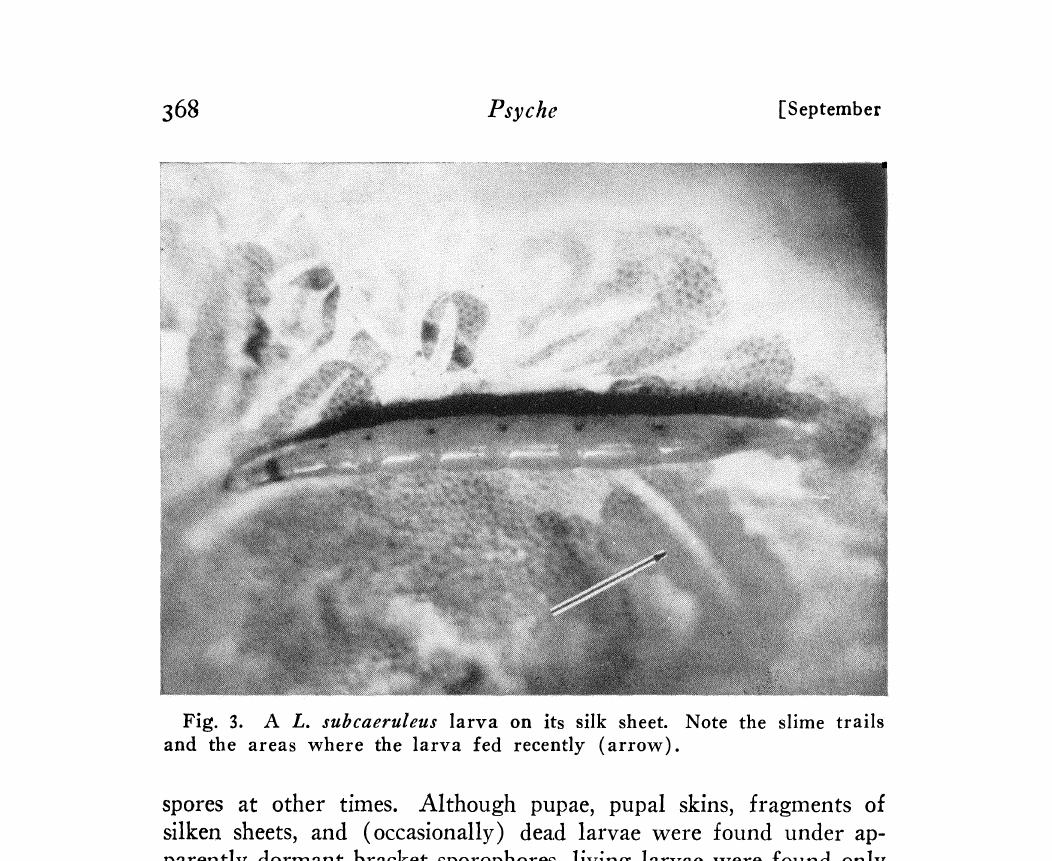
Fig. 3. A L. subcaeruleus larva on its silk sheet. Note the slime trails and the areas where the larva fed recently